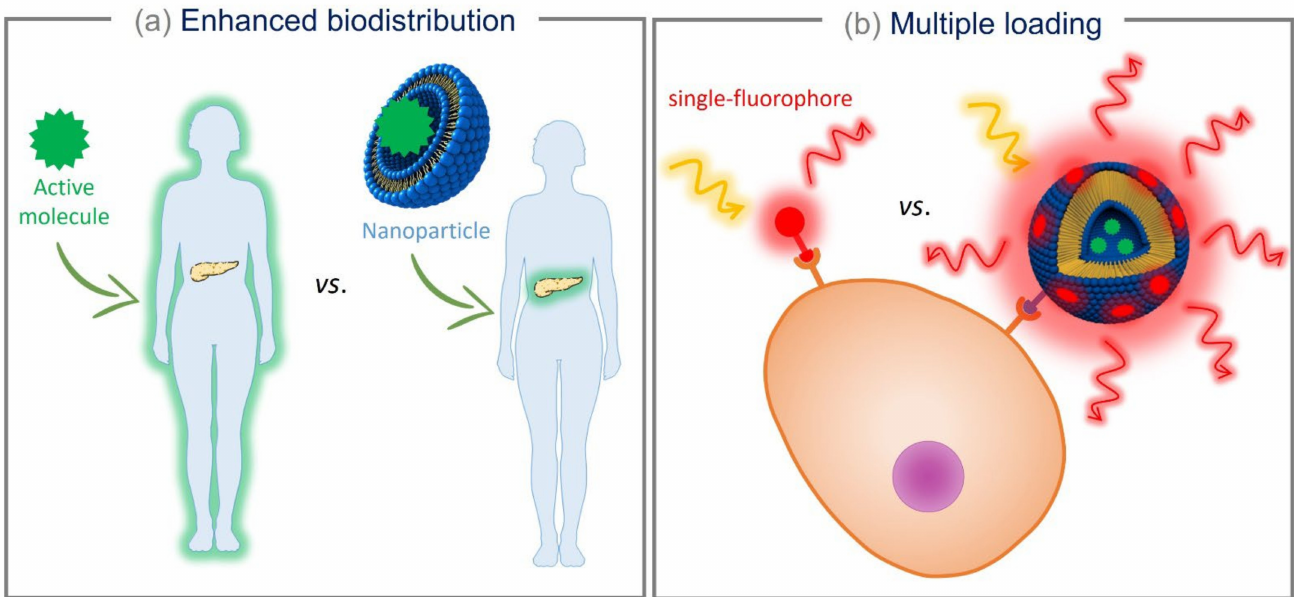
Figure 2. Schematic representation of two of the advantages of using nanoparticles for drug delivery and bioimaging. ( a ) Enhanced biodistribution due to passive or active tissue targeting. ( b ) Multiple fluorophores loading with the related brightness